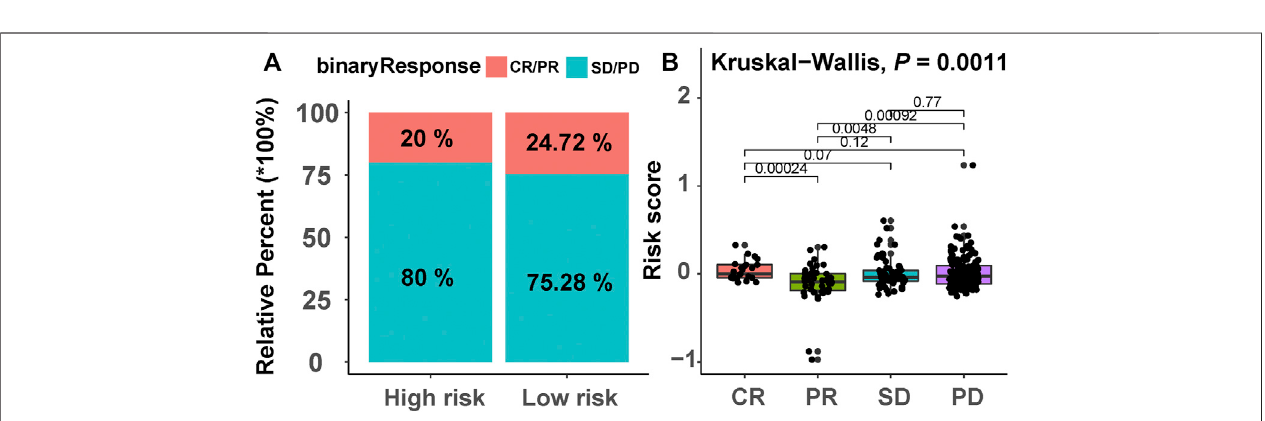
FIGURE 10 | Chemotherapeutic drug response of the prognostic model. (A) The proportion of patients with different drug responses in the high- and low-risk groups. CR, complete response; PR, partial response; SD, stable disease; PD, progressive disease. (B) Distribution of patients with different drug response groups based on the risk score.